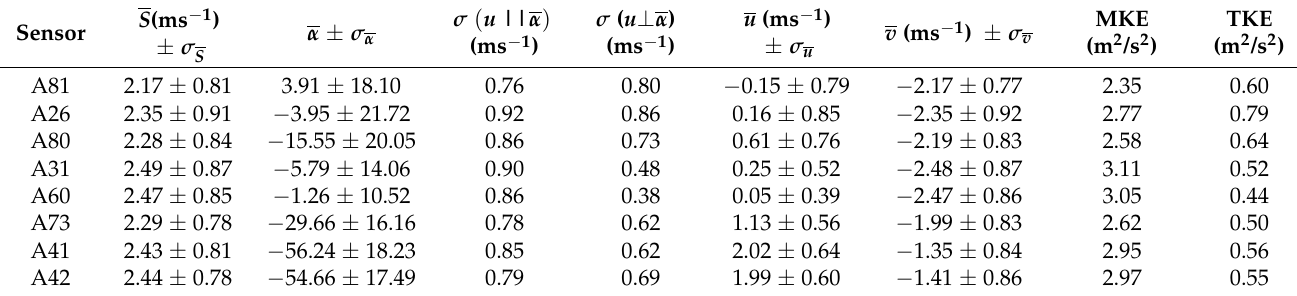
Table 1. Statistics computed using wind data from the eight anemometers used in the study.